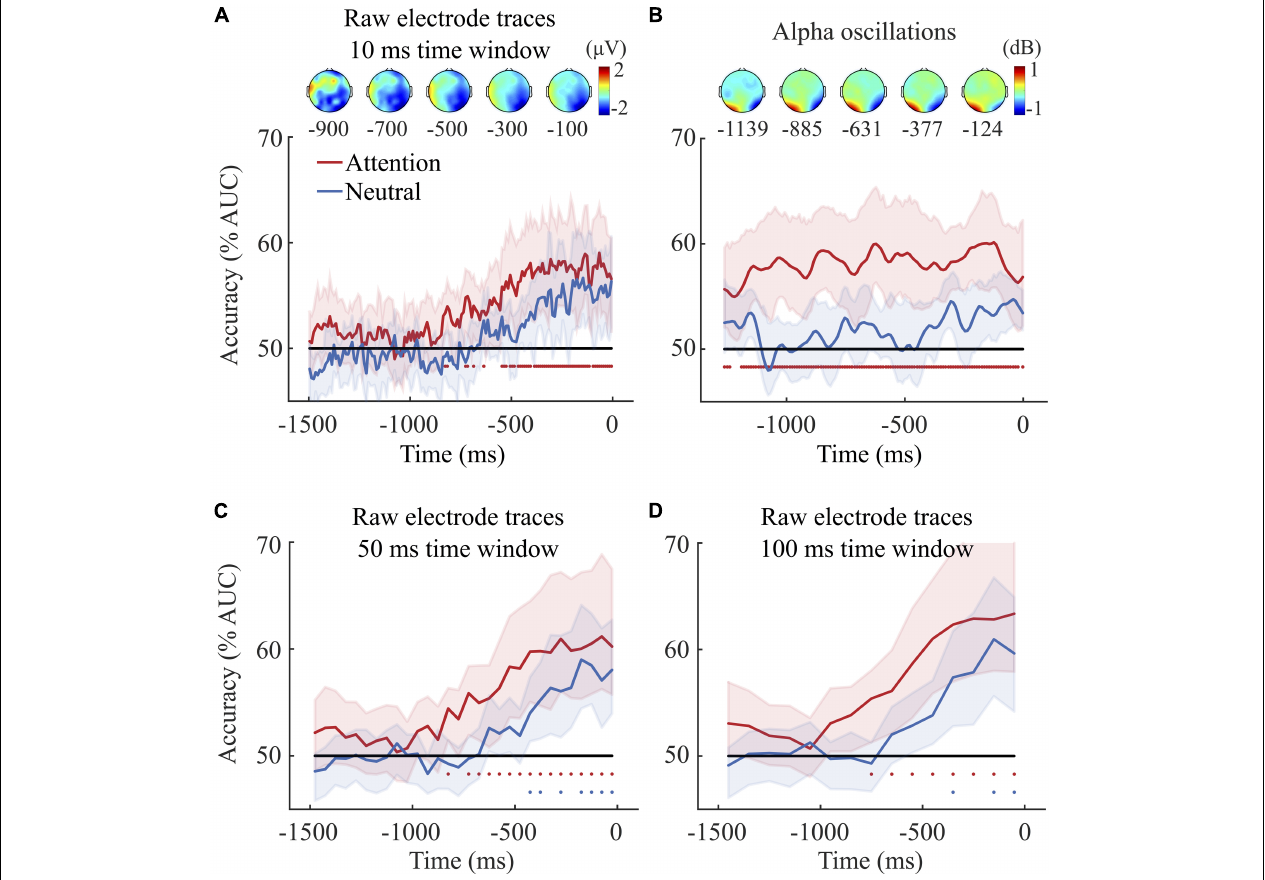
FIGURE 2 | (A) Decoding accuracy based on raw activity traces (10 ms time window classifier). The classifier was trained to discriminate left from right target trials as a function of time. 0 ms indicates the onset of participants’ response for both the attention (in red) and the neutral condition (in blue) for raw channel traces. The classifier could dissociate left from right target trials only when target location was cued. Classification accuracy (AUC) was significantly above chance from about 826 ms before the onset of participants’ response. The red/blue dots under the lines indicate significant difference from chance tested via permutation tests. At 826 ms before the onset of participants’ response, about 28.75% of the dots were moving coherently. Note that participants’ average discrimination threshold was 48.15%. Since the average response time was 1819 and 1985 ms in the attention and neutral conditions, respectively, the coherent motion started on average prior to the beginning of the EEG segments shown here 2 . The percentage of dots moving coherently at – 1500 and 0 ms was on average 9.65 and 52.31% in the attention condition, 14.13 and 56.92% in the neutral condition, respectively. The scalp distribution depicts the difference in brain activity between left and right target trials in the attention condition at five different 200 ms time windows prior to the onset of participants’ response with the midpoint of the window indicated under each on the graph. (B) Decoding accuracy for alpha power (8–13 Hz). The classifier could dissociate left from right target trials only when target location was cued. Classification accuracy (AUC) was significantly above chance from the beginning of the epoch, i.e., 1262 ms before the onset of participants’ response. Scalp topographies depict the distribution of alpha power (Event-Related Spectral Perturbations - ERSP) observed for left minus right target trials in the attention condition, at five different 200 ms time windows with the midpoint of each indicated underneath. Note that the average amplitude of alpha oscillation at each individual frequency was corrected with a 500 ms time-frequency baseline - from 200 to 700 ms after the onset of participants’ response. (C,D) The two bottom graphs depict the decoding accuracy (AUC) for the 50 and 100 ms time window brain potential classifiers. Classification accuracy for the 50 ms classifier was significantly above chance from 826 ms and 351 ms before the onset of participants’ response in the attention and the neutral condition, respectively. Importantly, at these time points, about 28.75% and 46.96% of the dots were moving coherently either upward or downward in the attention and neutral condition, respectively. Similar results were observed in the 100 ms time window classifier. Shaded areas represent bootstrapped confidence intervals.